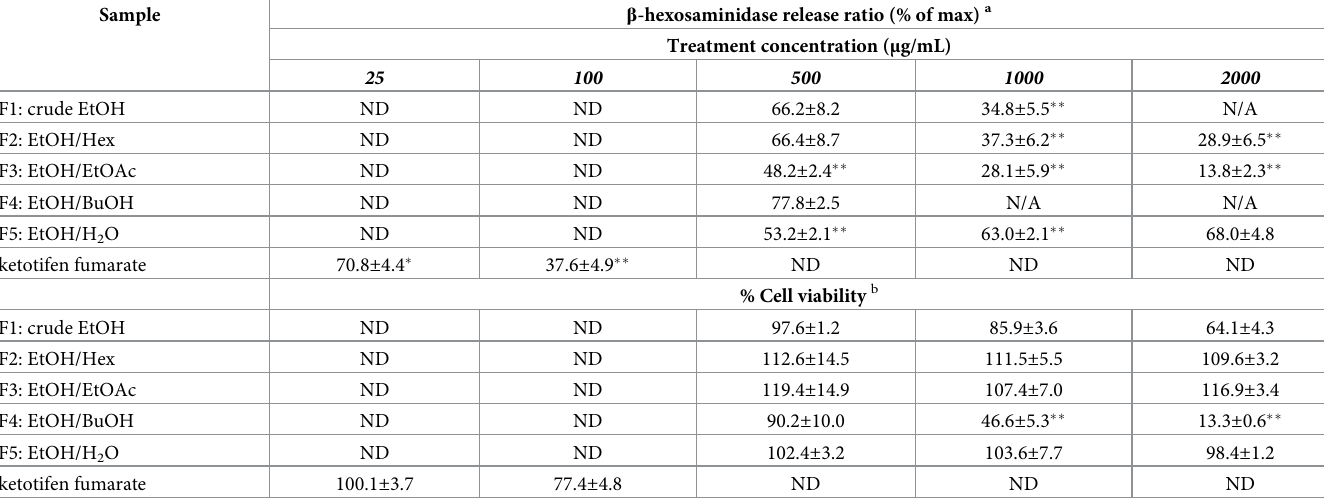
Table 1. Effects of X . tridentata extracts on IgE-mediated mast cell degranulation and cell viability of RBL-2H3 cells.